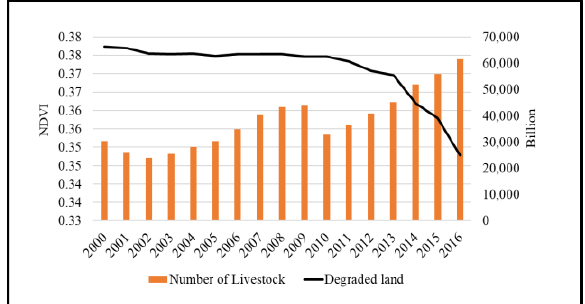
Figure 4. The relationship between the number of livestock and hotspot of degraded land,